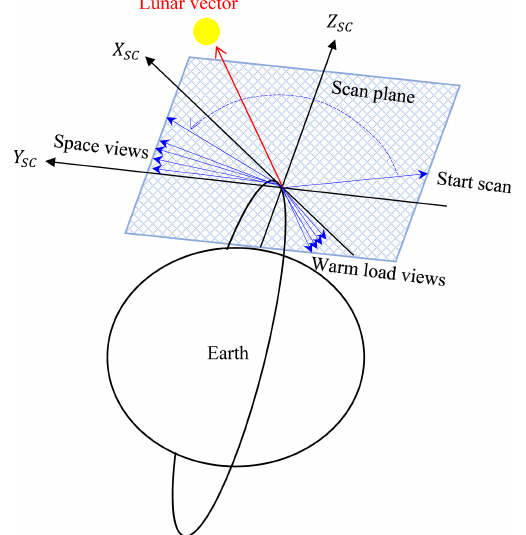
Figure 1. ATMS scan geometry when operating in pitch-over mode. X SC , Y SC , and Z SC are the axes of spacecraft coordinate system and its Y − Z plane is the scan plane. The lunar vector entered the scan plane as the spacecraft rotated about 180 ◦ pitch angle around Y SC .